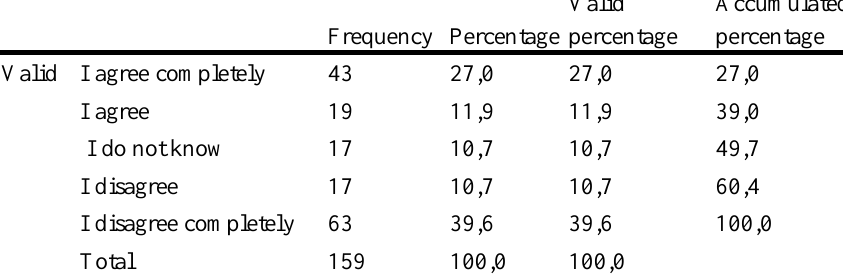
Valid percentage questionnaires´ results, question 17 “Students feel shy participating on bilingual